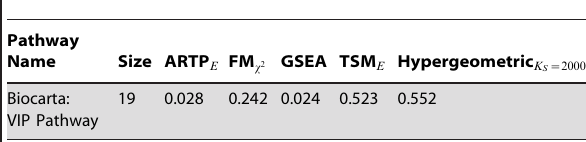
Table 6. Pathway Analysis of